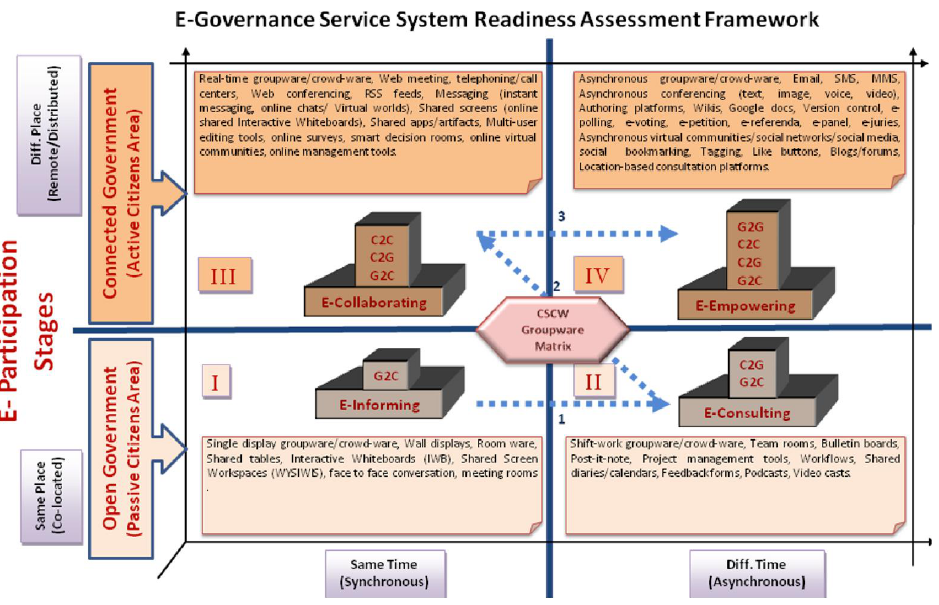
FIG. 5. E-GOVERNANCE SERVICE SYSTEM READINESS ASSESSMENT